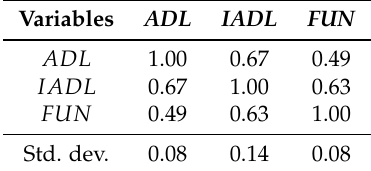
Table 2. Correlation coefficients and standard deviation of the dependence indicator